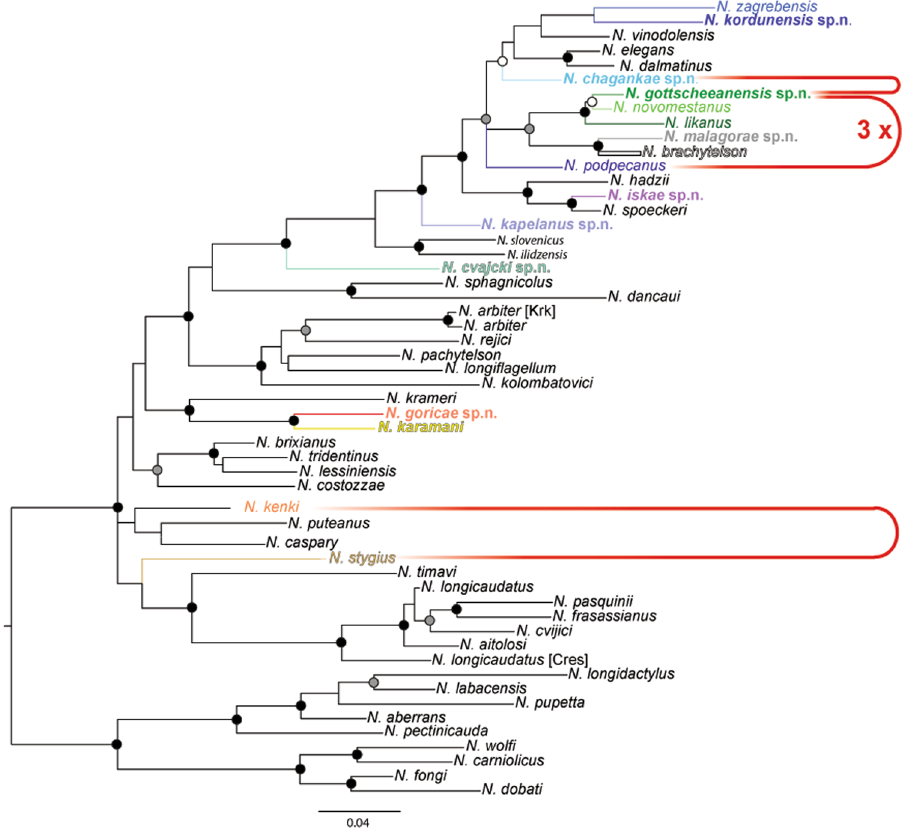
Figure 2. Phylogenetic tree reconstructed using Bayesian inference. Black and grey dots indicate posterior probabilities of 1 and > 0.95, respectively. Species of the Niphargus stygius complex are marked with colours as per Fig. 1. To simplify the presentation, we collapsed terminals of each species. The full species delimitation tree with 164 individuals is available in Supplementary Information 2. Species found in syntopies are labelled with red dots. Altogether, five syntopies were recorded; of these N. podpecanus and N. gottscheaensis were found three times